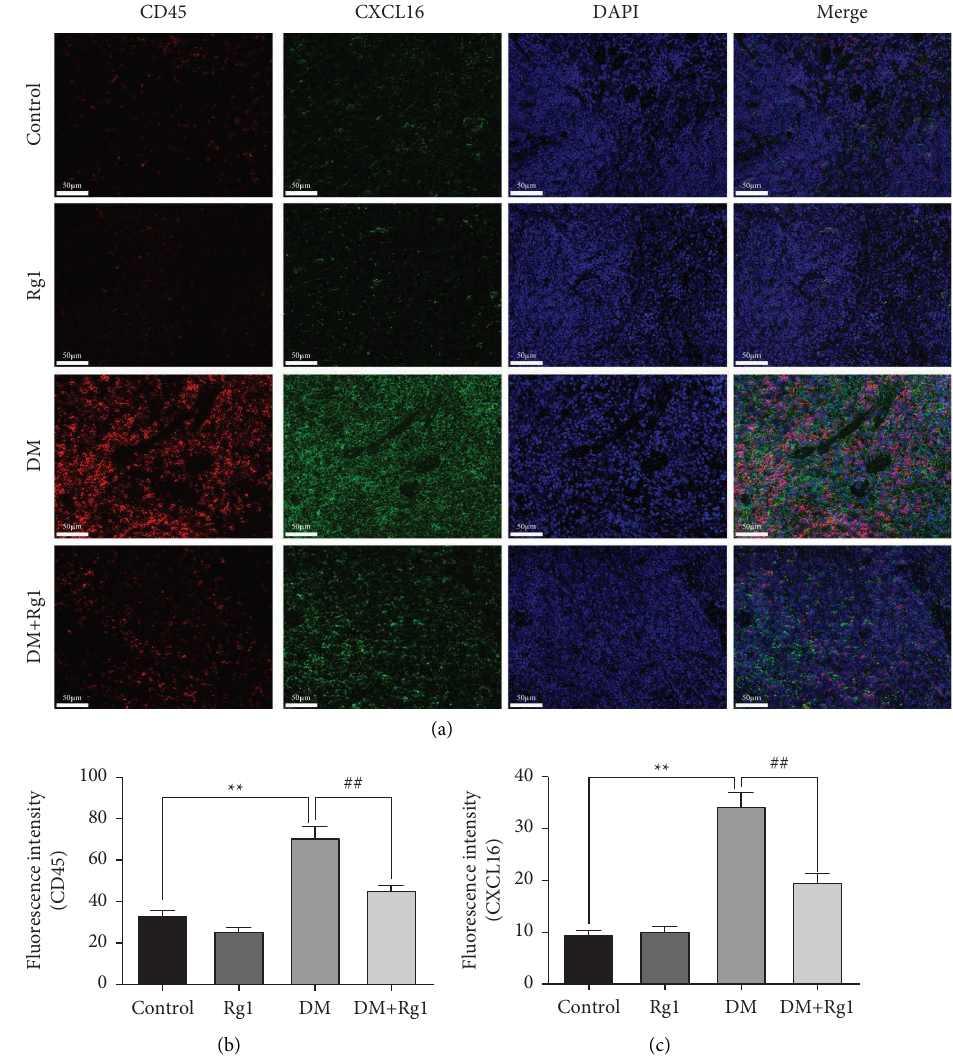
Figure 4: Te CXCL16 and CD45 proteins are expressed in the spleen through immunofuorescence. ( × 400, Scale: 50 μ m) (a–c) the expressions of CXCL16 and CD45 protein colocalization in the spleen. (Mean ± SD, n � 6) Te fuorescence intensity was detected to observe the protein expression. Te increase in CD45 indicated an increase in infammatory cell infltration. Tose results suggested Rg1 treatment improve infammation of the spleen in type 1 diabetes mice relating to reducing CXCL16. ∗∗ p < 0 . 01, vs. the control group; ## p < 0 . 01 vs. the DM